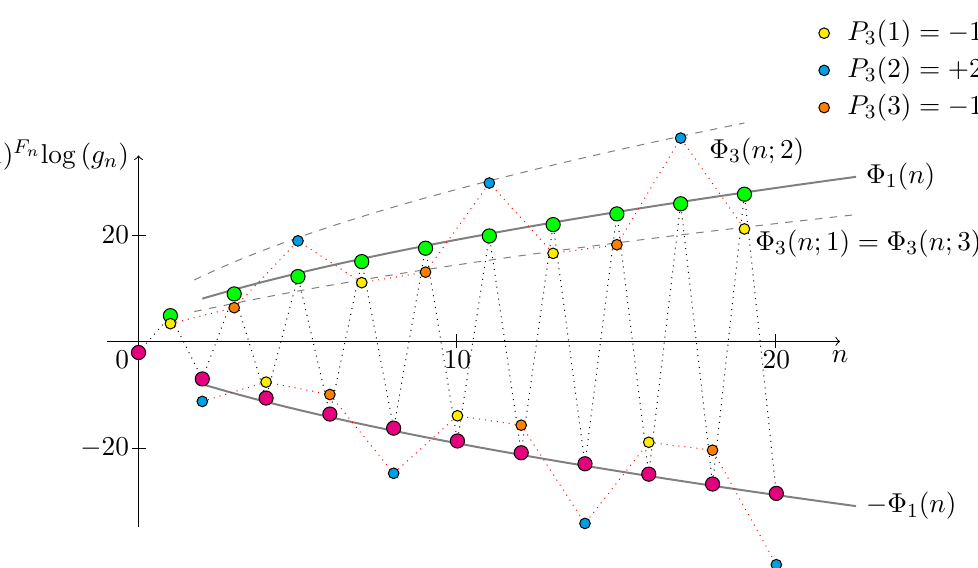
Figure 2 . A schematic plot representing the spectrum of an anti-D p -brane on top of an O p -plane, including the terms at leading order, for α = 1 , and the (magnified) corrections at next-to-leading order, for α = 3 . One has to consider bosons (odd n ) and fermions (even n ) separately. Then, levels n = 1 mod 3 have corrections multiplied by the value P (1) = − 1 , levels n = 2 mod 3 have 3 corrections multiplied by the value P (2) = +2 and levels n = 3 mod 3 have corrections multiplied 3 by the value P (3) = − 1 . For each different value the function P ( n ) can take, one can individuate 3 α a different interpolating function, both for bosons and for fermions. Evidently, the average of such interpolating functions vanishes, in both the bosonic sector and in the fermionic sector,